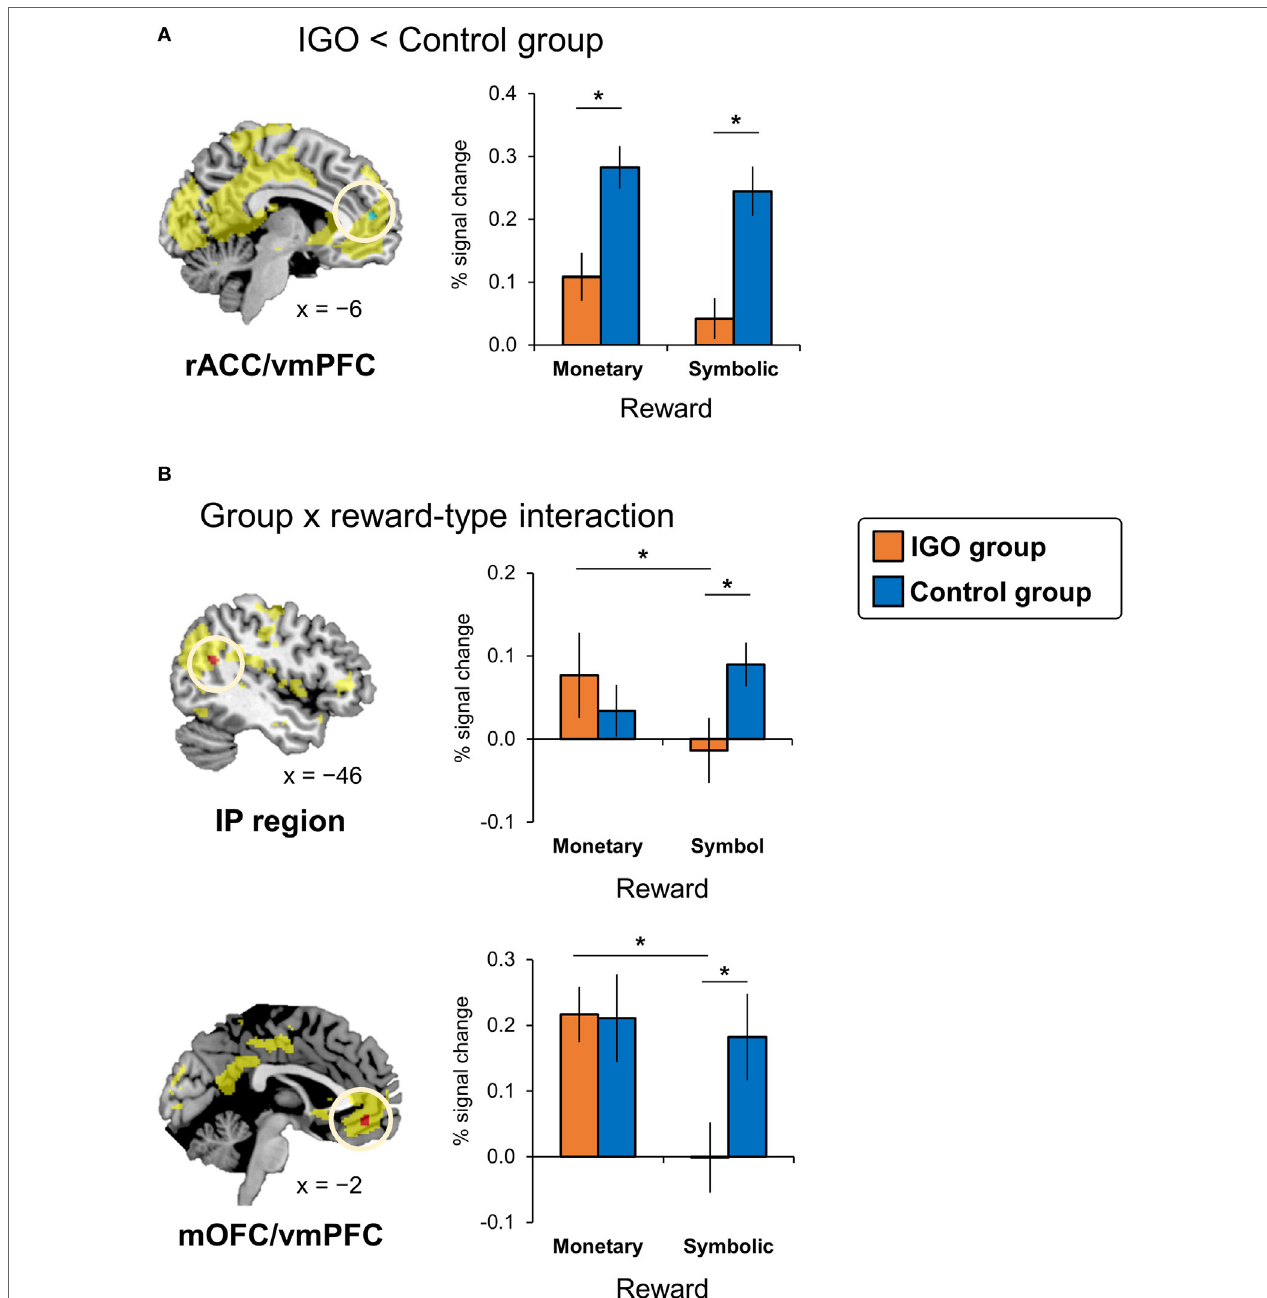
FigUre 3 | Internet game overuse (IGO) associated differences in brain activations during reward processing. (a) The IGO group showed reduced activations for reward in the left rostral anterior cingulate cortex/ventromedial prefrontal cortex (rACC/vmPFC) region (shown in green) indicated by a significant group main effect [IGO (monetary reward + symbolic reward) vs. Control (monetary reward + symbolic reward) ]. (B) The left inferior parietal (IP) region and medial orbitofrontal cortex/ventromedial prefrontal cortex (mOFC/vmPFC) showing a significant interaction effect between group and reward types (shown in red) [(IGO monetary reward > IGO symbolic reward ) vs. (Control monetary reward > Control symbolic reward )]. The regions shown in yellow indicate areas whose activations were greater for reward relative to penalty in the voxel-wise analysis of all participants.